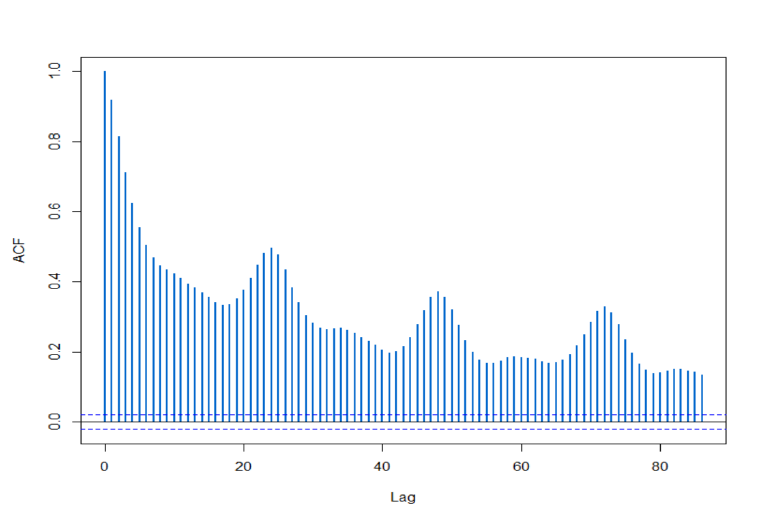
Figure 7. Sample autocorrelation function of hourly values for NO 2 concentrations from Blanchardstown air quality monitoring station over the initial 86 h period. Software: R-programming [56].